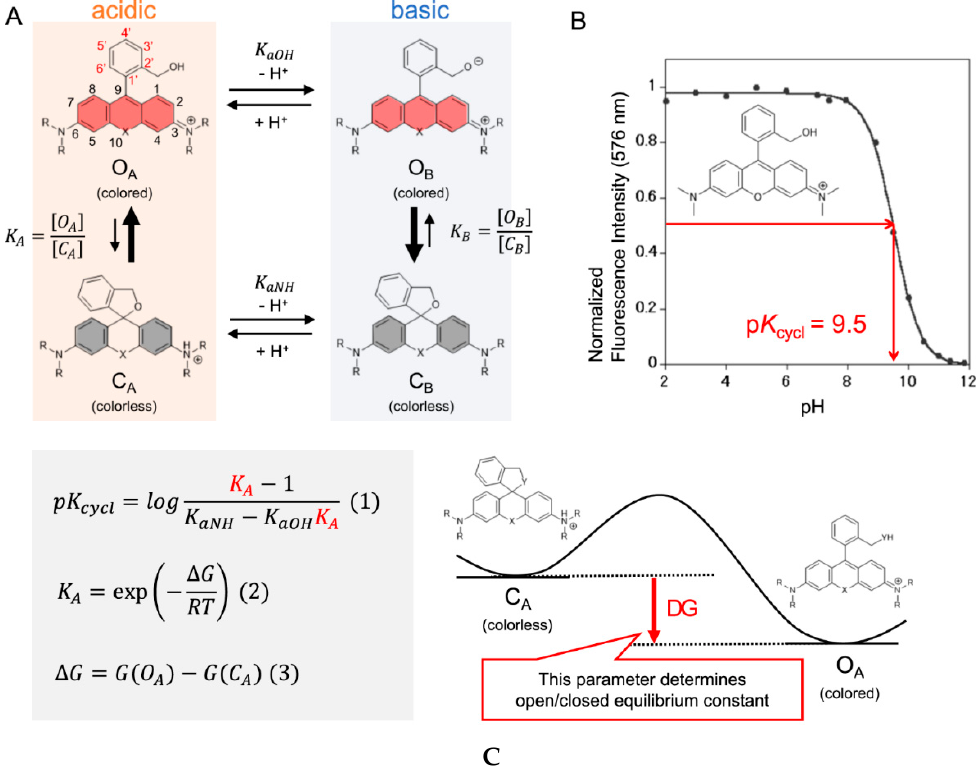
Figure 29. Intramolecular spirocyclization of HMR derivatives. ( A ) Acid–base equilibrium of HMR derivatives; ( B ) Correlation between pH and normalized fluorescence intensity of HMTMR; ( C ) Formula for pK cycl based on statistical mechanics and the visualization of Δ G. Adapted with permission from [44].